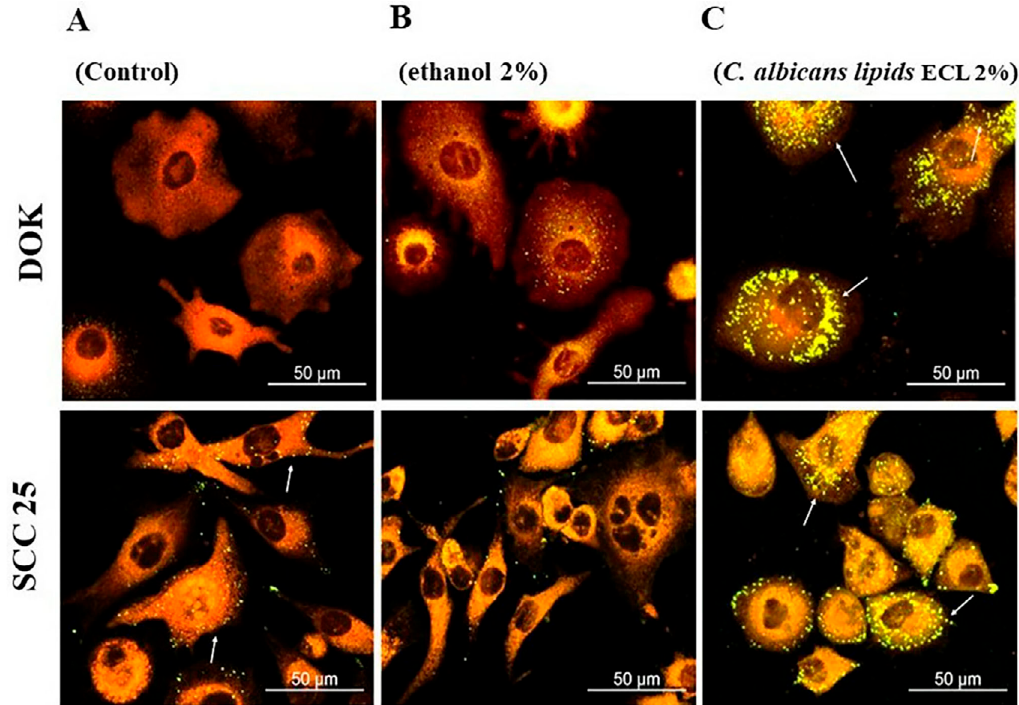
Figure 4- Confocal laser screening microscopy (CLSM) for DOK and SCC 25 cells cultured with ECL of C. albicans biofilm. CLSM of LD in DOK and SCC 25 cells after culturing for 72 hours with ECL (2% v/v) of C. albicans . (A) DOK and SCC 25 cells (control), (B) DOK and SCC 25 cells (vehicle), and (C) DOK and SCC 25 cells (ECL 2% v/v), LD vesicles (arrows), n=6.